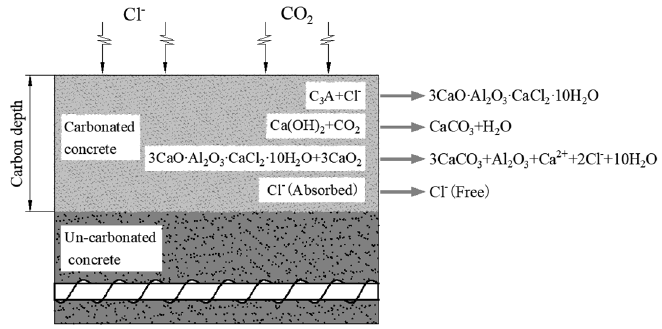
Figure 1. Interaction of chloride ion and carbon dioxide in concrete.